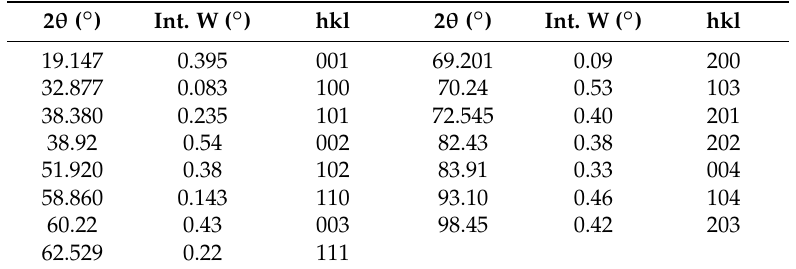
Figure 1. ( A ) The measured and simulated XRD spectra (the smaller the value of R wp , or the closer the value of S to 1, the better is the match between the measured and simulated data), and ( B ) the simulated XRD diffraction spectra with strong preferred orientation of the [001] type (r n = 1 (sphere) without preferred orientation; r n < 1 with the preferred orientation by plate crystallites; and r n > 1 with the preferred orientation by needle crystallites). Table 1. FWHM ( β ) of the measured peaks of Ni(OH) 2 after the correction of the instrumental broadening by external standard method (Si) from Rigaku.